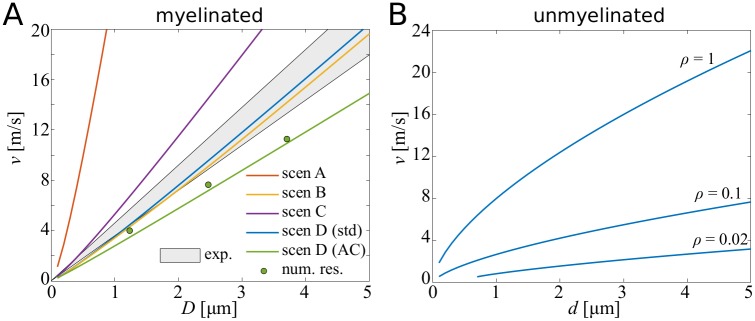
Propagation velocity as function of fibre diameter and axon diameter.A: In myelinated axons, the relationship between velocity and fibre diameter is nearly linear, with a slightly supralinear relationship at small diameters. Here we compare the different scenarios with experimental results (grey-shaded area). B: In unmyelinated axons, the propagation speed increases approximately with the square root of the axon diameter. Here, ρ indicates the relative ion channel density compared with a node of Ranvier. Decreasing the ion channel density results in slower action potential propagation.